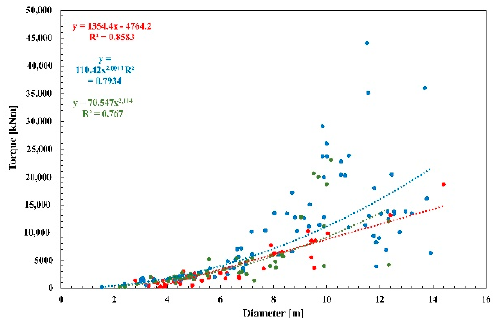
Figure 2. Correlation between diameter and torque. Red: open TBM; blue: single shield TBM; green: double shield TBM.